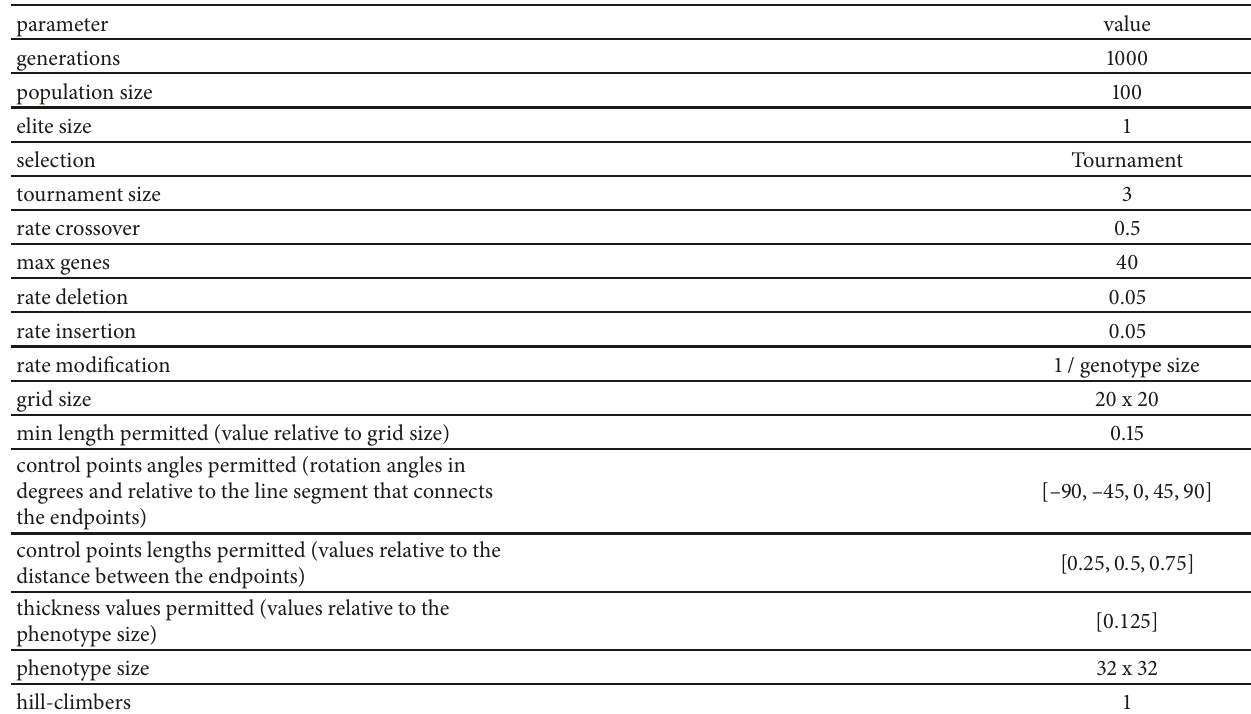
Table 3: Experimental Parameters.